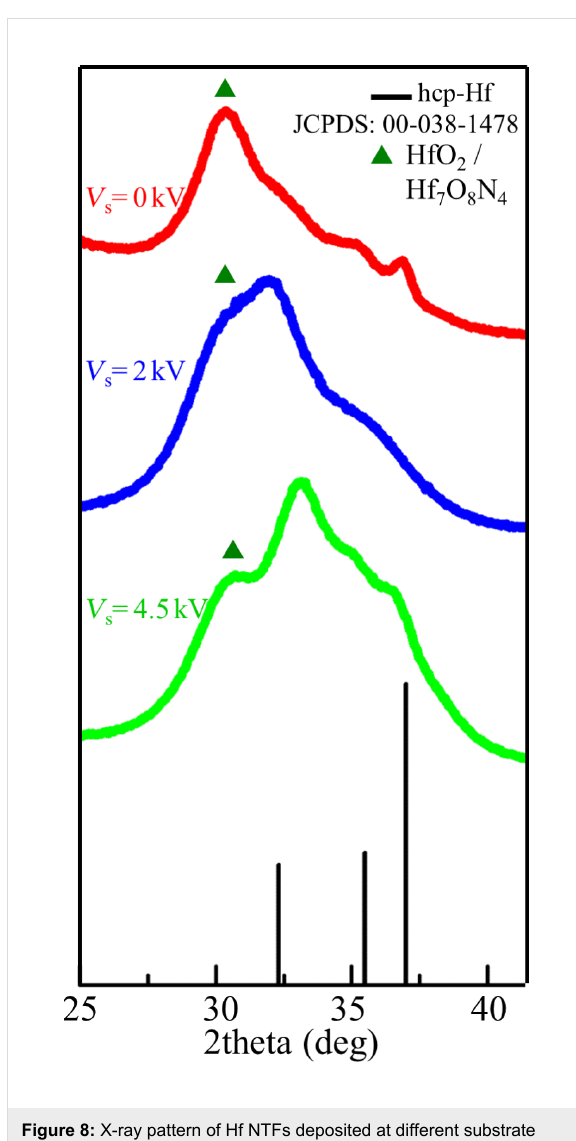
Figure 8: X-ray pattern of Hf NTFs deposited at different substrate voltages V s = 0, 2 and 4.5 kV.